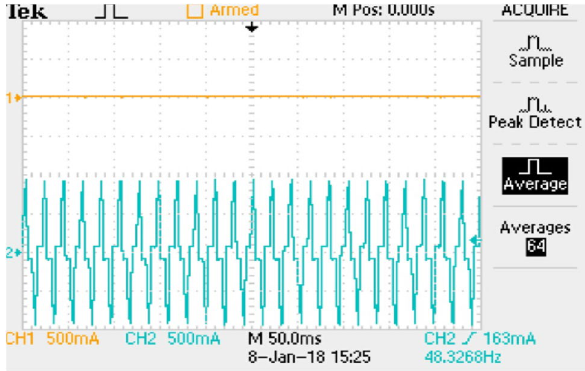
Fig. 11 EGLC current under zero consumer